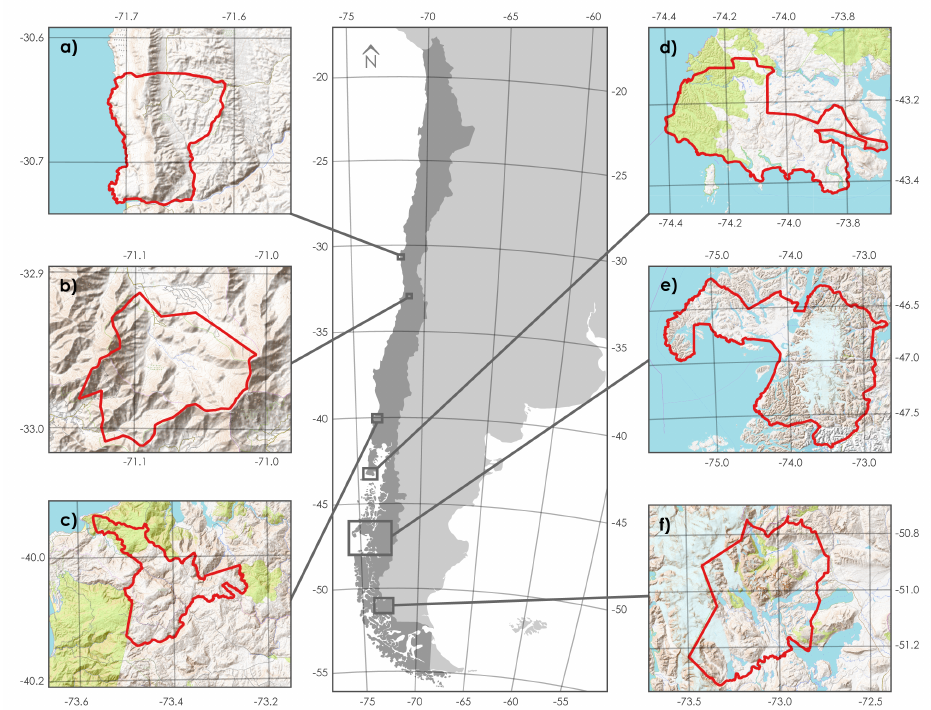
Figure 1. Map of the study area showing National Parks: ( a ) Fray Jorge, ( b ) La Campana, ( c ) Alerce Costero, ( d ) Tantauco, ( e ) San Rafael and, ( f ) Torres del